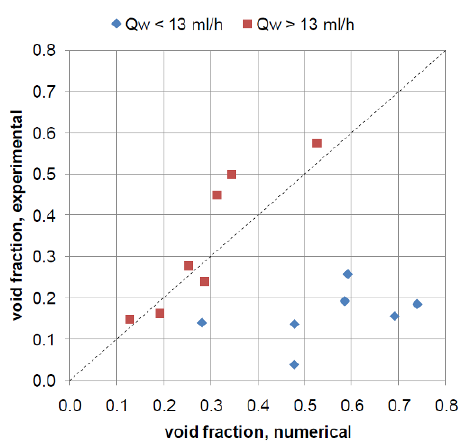
Figure 12. Comparison of numerical and experimental void fraction